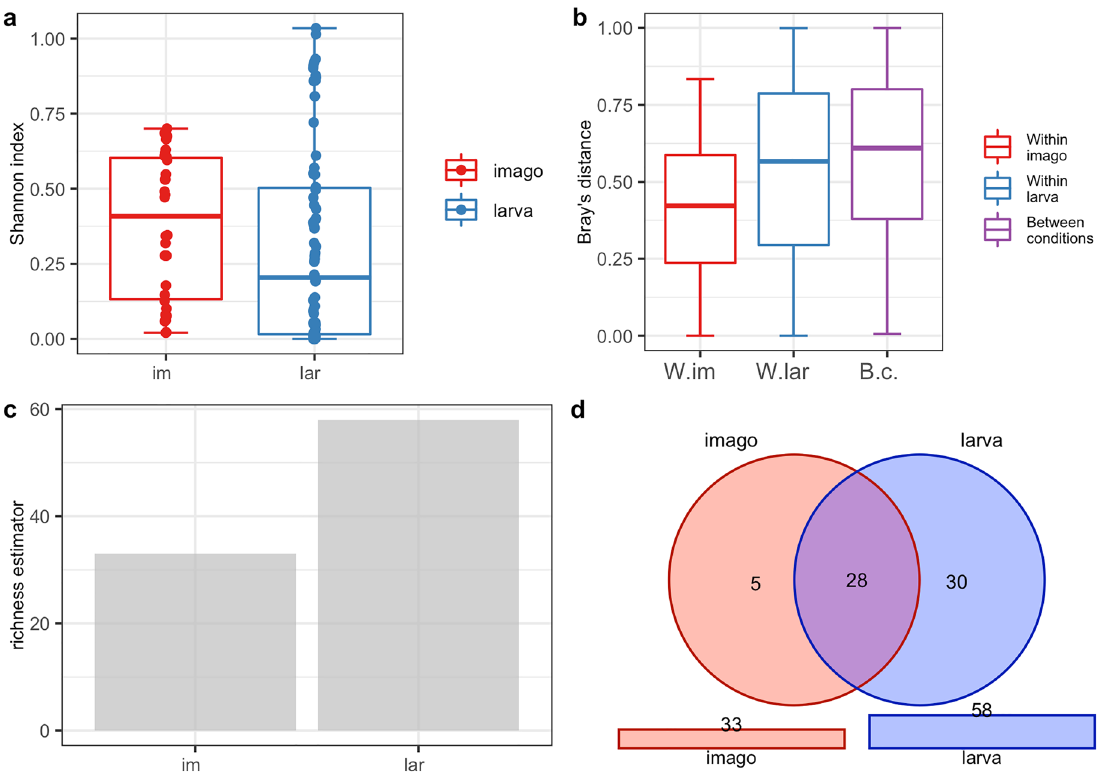
Figure 3. Diversity and richness of CLB bacterial community at the species level depending on the developmental stage: ( a ) alpha-diversity (Shannon index); ( b ) beta diversity (Jaccard distance); ( c ) level of richness (jacknife coefficient); ( d ) a number of shared species between imagoes and larvae (Venn’s diagram). im: imago; lar: larva; W.im: within imago; W.lar: within larva; B.c: between